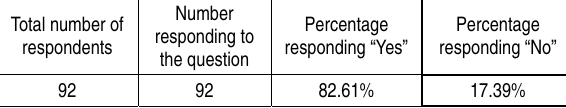
Table 1. Use of performance measurement